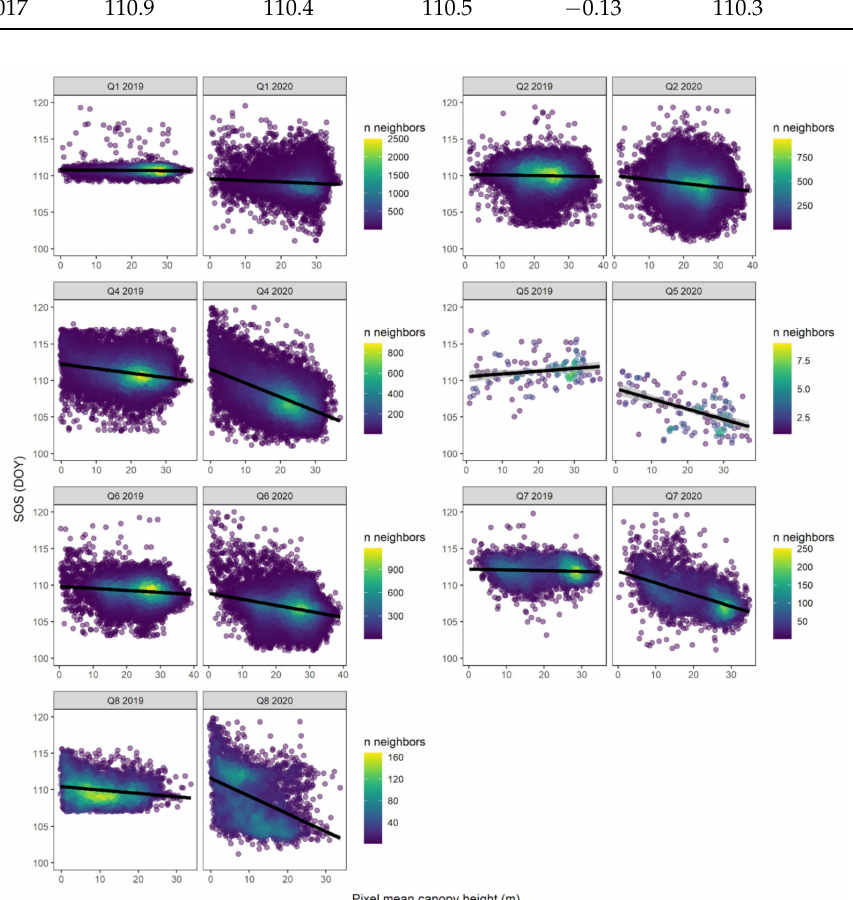
Figure 6. Effects of pixel mean canopy height (m) on SOS (DOY), derived from Sentinel-2 pixels covering all State Forest areas in which F. sylvatica is the dominant species. Names on top of the different panels refer to quadrant names followed by year. Each point represents a pixel, and is colored according to the point density, i.e., number of neighbors (“n neighbors”), in the plot. Number of neighbors is defined according to the default options in the geom_pointdensity function as part of the ggplot2 package [81] in R